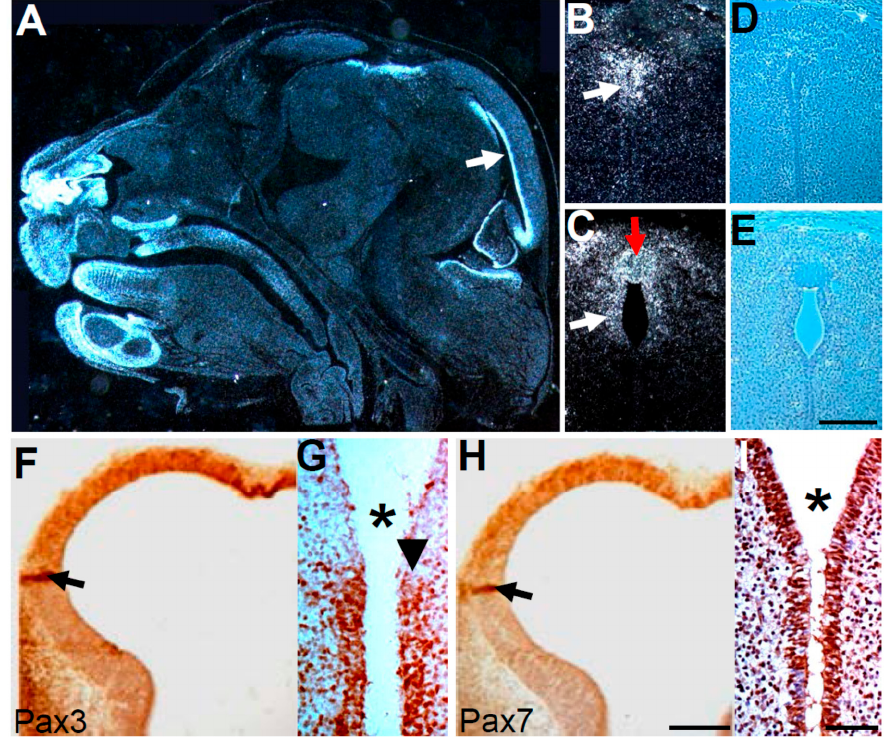
Figure 7. Analysis of Pax3 and Pax7 spatiotemporal expression patterns, Cre expression limits and cell proliferation during cerebral ventricular development. ( A – C ) In situ hybridization detection of Pax3 mRNA in E15.5 wild-type heads show active expression in ventricular epithelium (arrow) and multiple craniofacial structures ( A ). Coronal E14.5 sections cut at the subcommissural organ (SCO, indicated by the red arrow in C ) level of Pax3 flox/flox /Wnt1-Cre mutant ( B ) and control ( C ) reveal Pax3 is still expressed in the ventricular epithelium (white arrow) comparable to control ( C ), despite collapse of the ventricular opening in mutants; ( D , E ) Phase contrast images of B , C , illustrating the lack of a distinct subcommissural organ in the mutant D ); ( F , H ) Immunohistochemical detection of Pax3 ( F ) and Pax7 ( H ) protein on adjacent telencephalic vesicle sections at E10, reveals co-localization in the majority of the neuroepithelium, with especially robust expression (brown) in the lamina terminalis. The black arrows point to intense artificial staining due to tissue folding; ( G , I ) Immunohistochemical detection beta-galactosidase expression following lineage mapping at E13.5 for Pax7 − Cre /R26r ( G ) and Wnt1-Cre/R26r ( I ) following Cre-mediated activation of R26r reporter. While Wnt1-Cre marks the ependymal layer from third ventricle (3v) through aqueduct ( I ), Pax7 − Cre only marks the ependymal layer of 3v (arrow points to the 3v-aqueduct junction and asterisk indicates aqueduct). Scale bars: B–E = 100 µm; F,H = 200 µm; G,I = 50 µm.